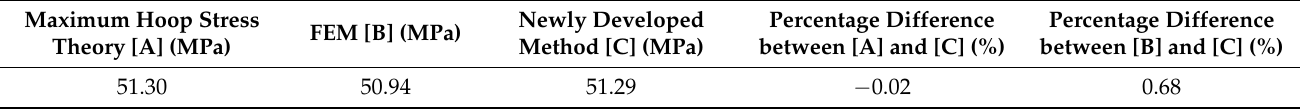
Table 12. Comparison of the intact pressure values of the pristine pipe.